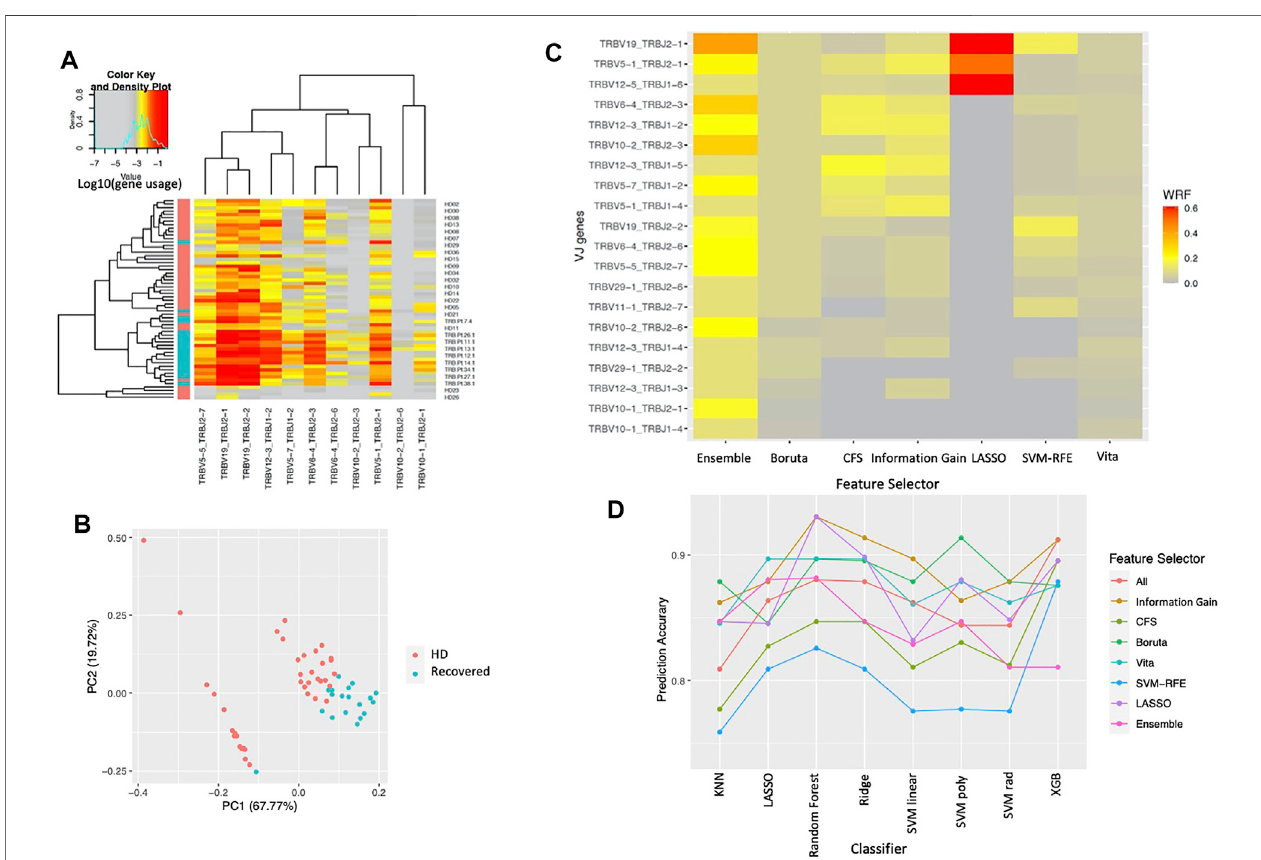
FIGURE 2 | The results for COVID-19 dataset. (A) TCR VJ gene usage heatmap. VJ gene usage was assessed for each sample. Each column represents an individual single VJ gene combination, and each row represents an individual subject with red bar and green bar in left side of the heat map representing healthy donors (HD) and COVID-19 recovered patients (Recovered), respectively. The heat represents the VJ gene usage, with red to grey representing increased to decreased gene usage, respectively. (B) Principal components analysis based on the selected VJ genes. Each dot represents a single subject with red and green representing healthy donors (HD) and COVID-19 recovered patients (Recovered), respectively. (C) Normalized selection frequency of the top selected VJ genes by each feature selection approach. Each row represents an individual single VJ gene combination, and each column represents the feature selection approaches. (D) Prediction accuracy based on the selected VJ genes by each feature selection approach for different classi fi cation methods. Each line presents the prediction accuracy for the corresponding feature selection approach based on the corresponding classi fi cation method